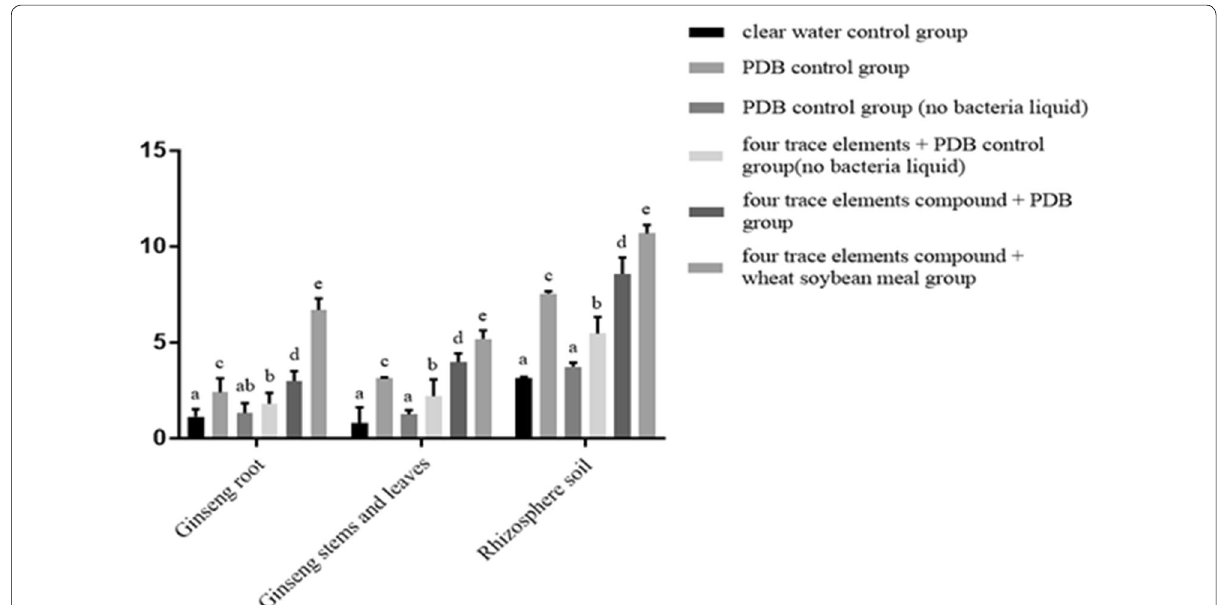
Fig. 6 Effect of trace elements on the colonization of Pp-7250 in ginseng roots, leaves and rhizosphere soil